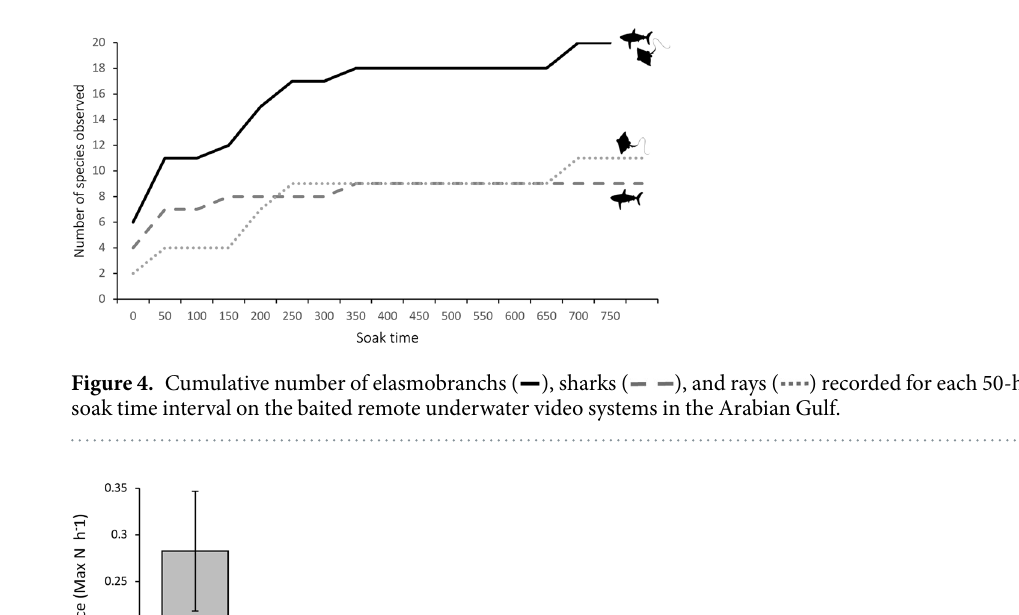
Figure 3. Images of elasmobranchs captured by the baited remote underwater video systems in the Arabian Gulf, ( a ) spottail shark Carcharhinus sorrah , ( b ) leopard whipray Himantura leoparda , ( c ) smoothnose wedgefish Rhynchobatus laevis .